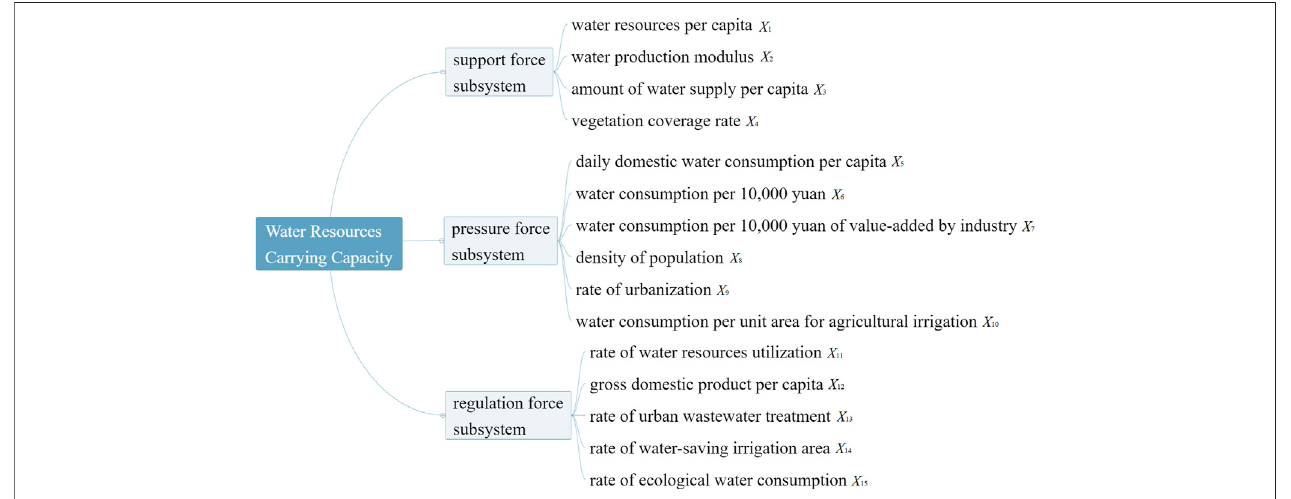
FIGURE 4 | Index system for evaluating the carrying capacity of water resources in Anhui Province.